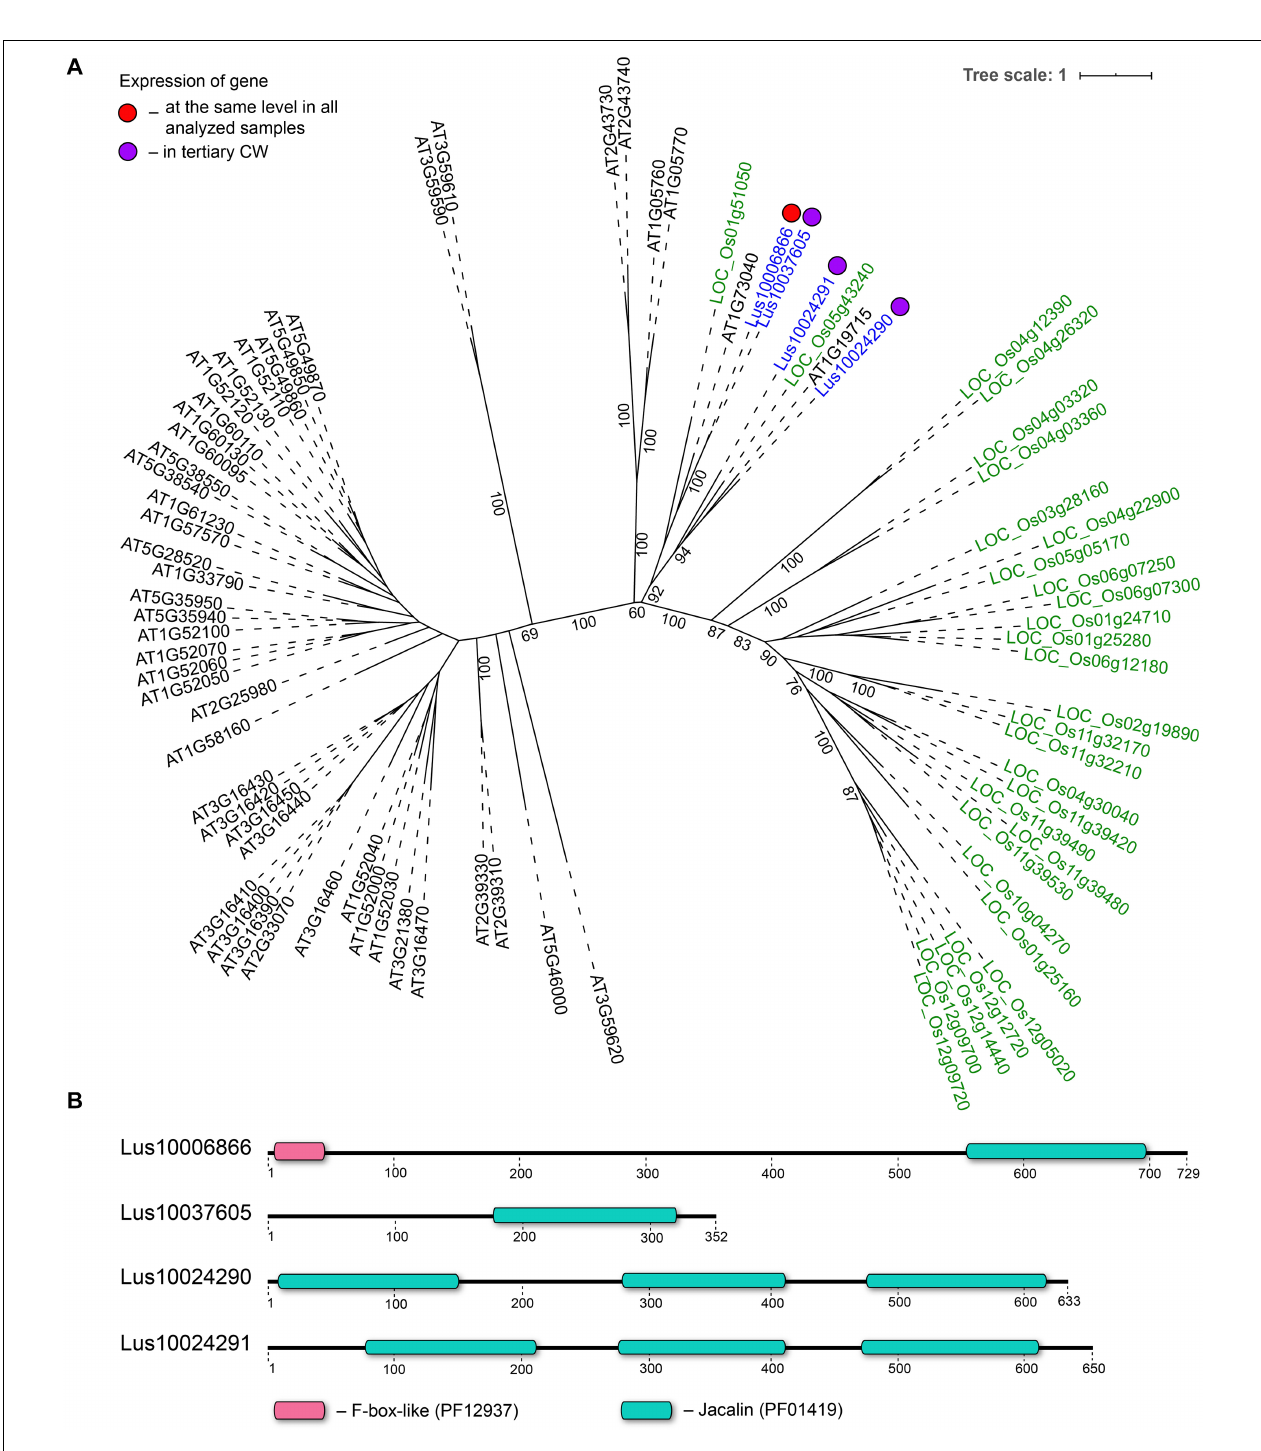
FIGURE 8 | Phylogenetic dendrogram (A) of jacalin (PF01419) lectin family members of Arabidopsis thaliana , Linum usitatissimum , and Oryza sativa (Japonica Group) and domain size and distribution (B) in their protein sequences. (A) The A. thaliana gene names are given in black font, L. usitatissimum gene names are given in dark blue font, and O. sativa gene names are given in green font. The different colored dots next to L. usitatissimum gene names indicate genes with different expression patterns. The criteria used for different expression pattern identification as follow: red, the mean values of tau-score < 0.15 across all samples; purple dots, DEGs upregulated in samples with tertiary CW. Flax genes with red and purple dots are listed in Tables 2 , 5 , respectively. Numbers indicate the ultrafast bootstrap support values for some branches. (B) The domain size and distribution are shown according to results of domain search using the InterProScan tool of the InterPro database (https://www.ebi.ac.uk/interpro/; Mitchell et al., 2019). Numbers indicate the length of amino acid sequences. Abbreviations: DEGs, differentially expressed genes, a pairwise comparison log 2 FC ≥ 1; padj ≥ 0.01, CW, cell wall.